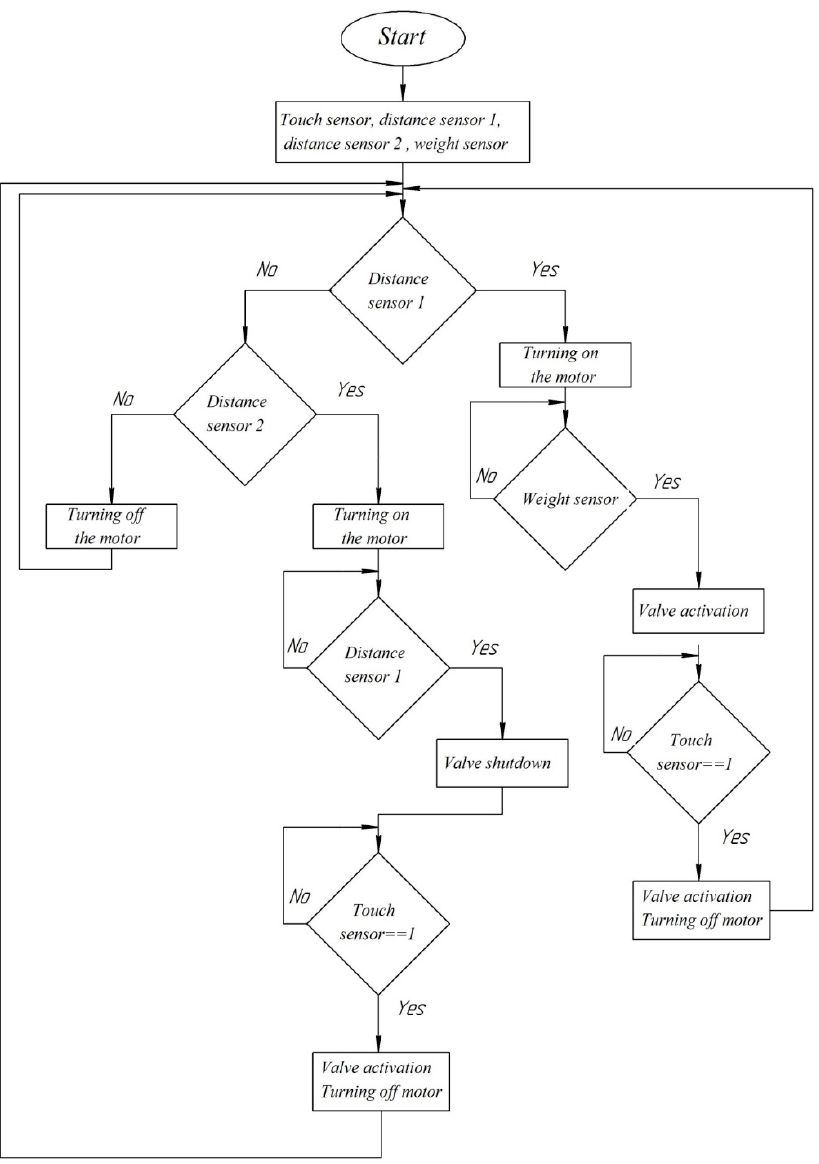
Figure 10. Block scheme of the PM with two sliders